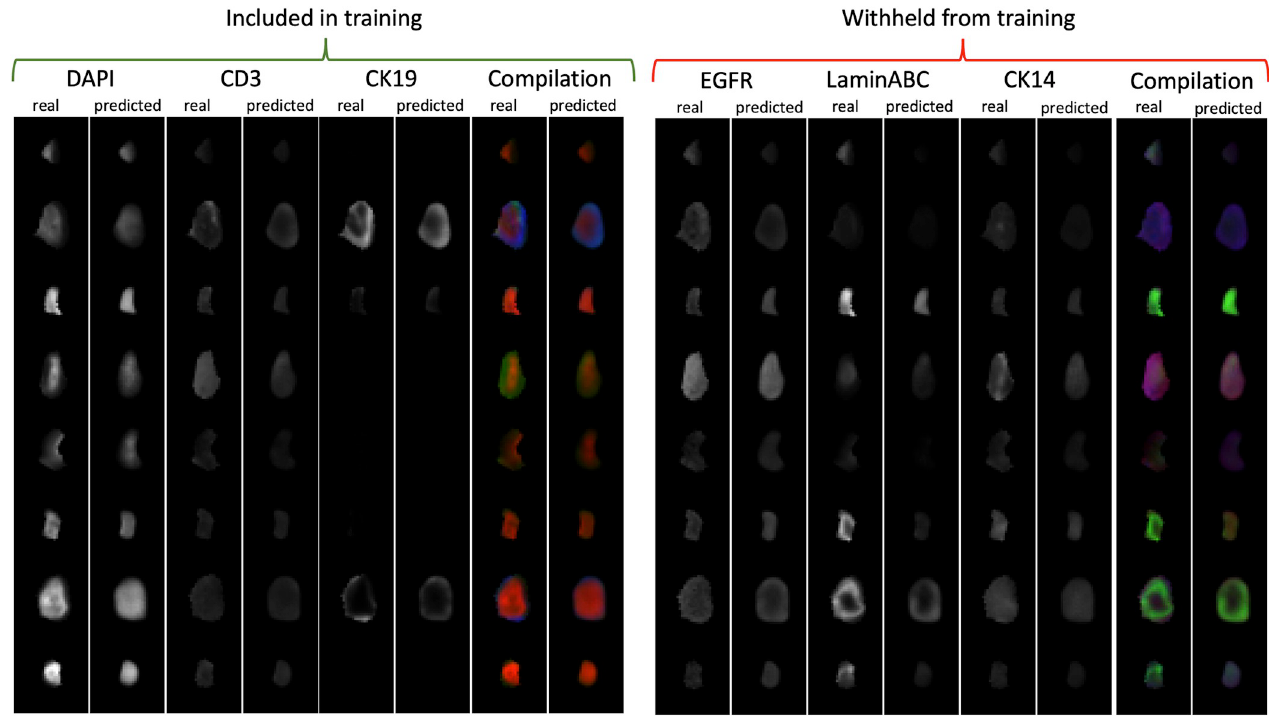
Fig 2. A proof of concept full panel imputation: 12 stains were randomly selected to create a reduced panel which were then used to train a ME-VAE to reconstruct the full panel of stains. Here we show a representative 3 stains from the included and withheld marker sets across 8 cells. Real and predicted staining and their compilation images are shown side by side to qualitatively demonstrate that a reduced panel can reconstruct relevant unseen information.